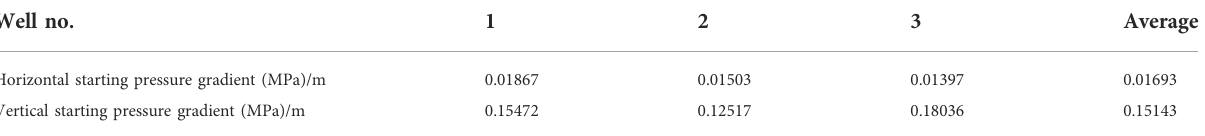
TABLE 3 Calculation of starting pressure gradient of Chang 6 reservoir. Well no.